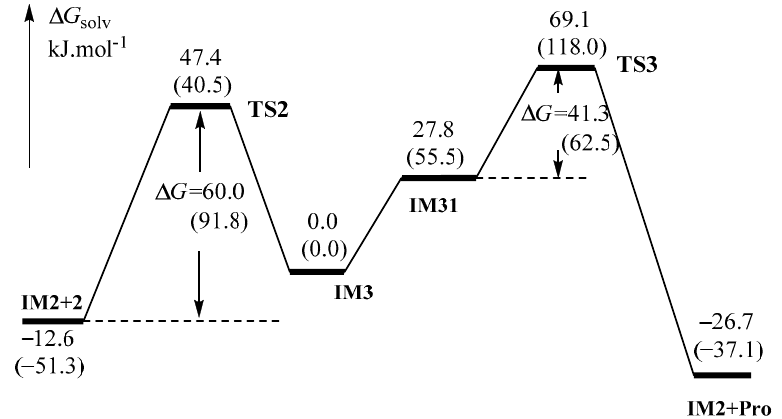
Figure 4. Evolution of energies along the reaction routes in the THF system. Δ G solv (in kJ mol -1 ) for various species are calculated at the M06(SMD, THF)/6-311+G(d,p) level; Δ G solv (in kJ mol -1 ) at the B3LYP(SMD, THF)/6-311+G(d,p) level are listed in parentheses.